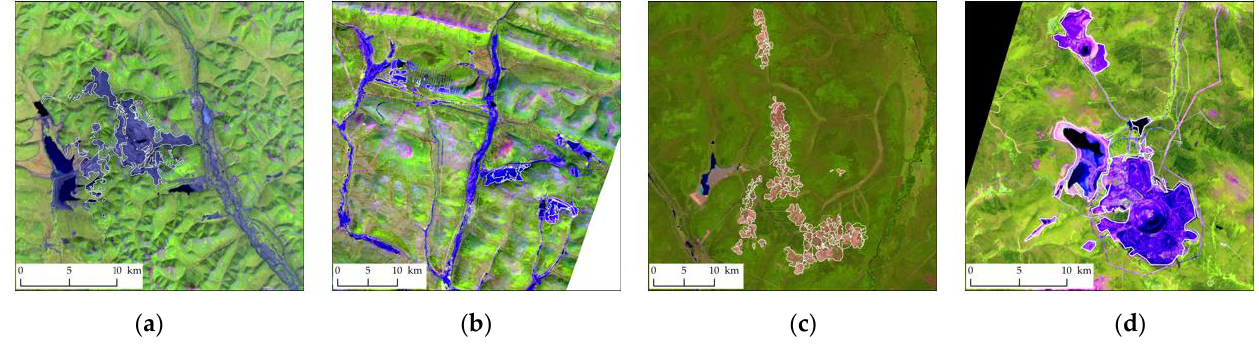
Figure 1. Area of disturbances from Landsat-8/OLI images of 2015 – 2020 for technogenic plots of ( a ) NMP (Magadan Region), ( b ) VMP (Irkutsk Region), ( c ) KMP (Republic of Sakha (Yakutia)), and ( d ) OMP (Krasnoyarsk Region).